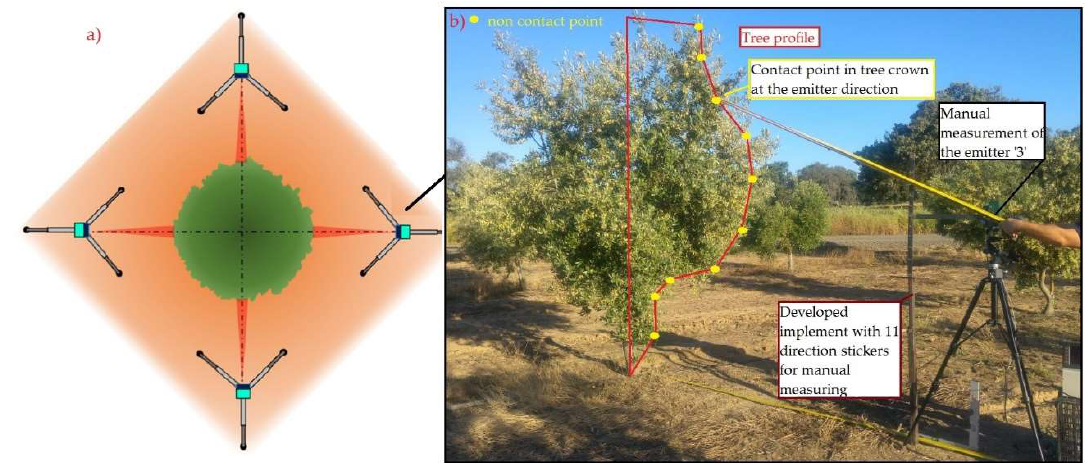
Figure 6. ( a ) Measurement location in the isolated tree test. ( b ) Use of the implement for measuring the contact point in tree at the emitter direction.